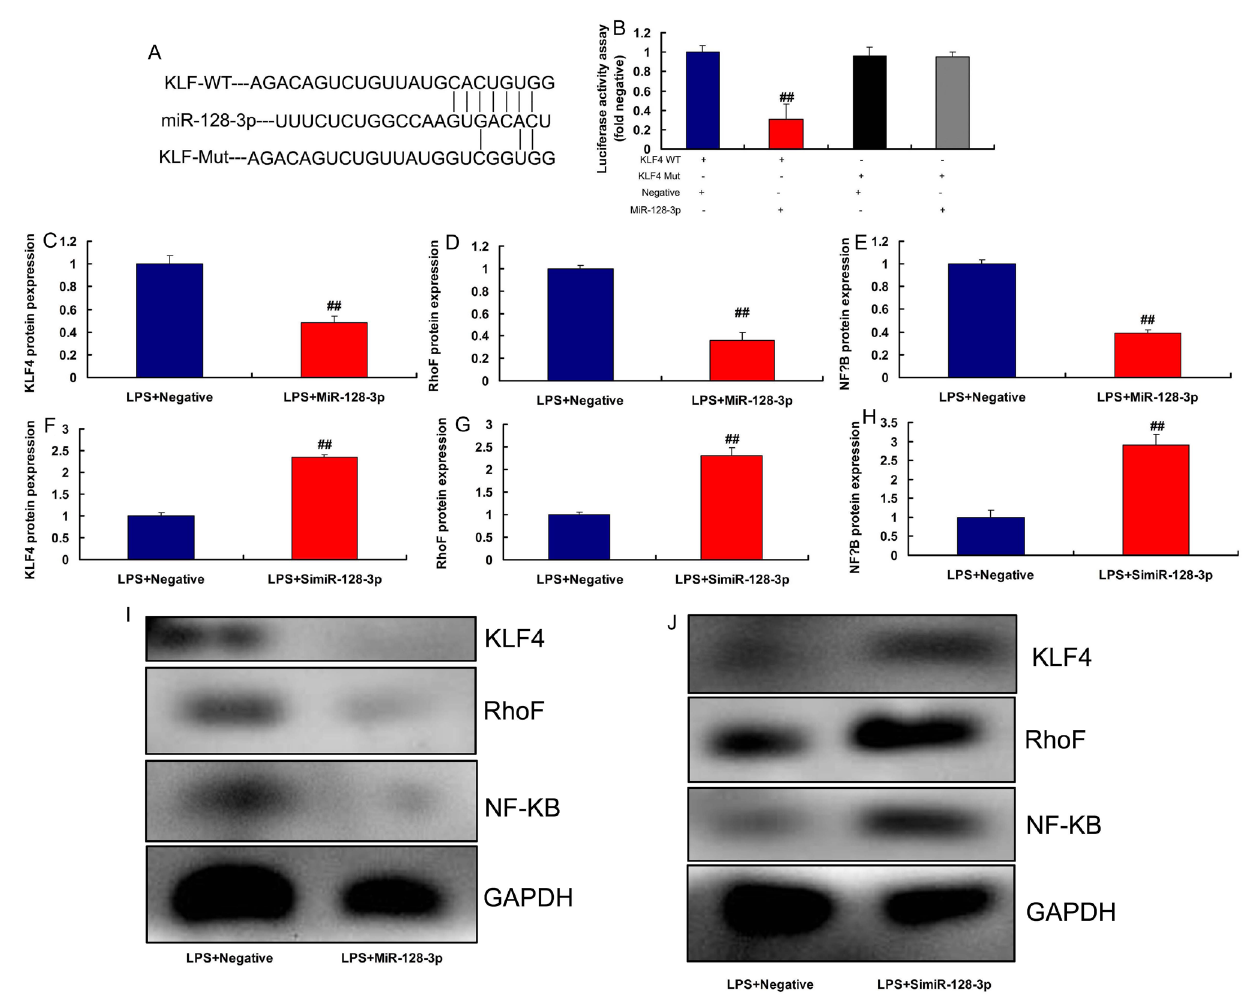
reporter plasmid containing wild type (WT) or mutant (Mut) KLF4 was cotransfected with miR-128-3p (A and B), KLF4, RhoF, and nuclear factor kappa B (NF-κB) protein expressions (C, D, E, and I) by overexpression of miR-128-3p; KLF4, RhoF, and NF-κB protein expressions (F, G, H, and J) model by miR-128-3p group; LPS+simiR-128-3p, LPS-induced in vitro model by simiR-128-3p group. ## P<0.01 compared with